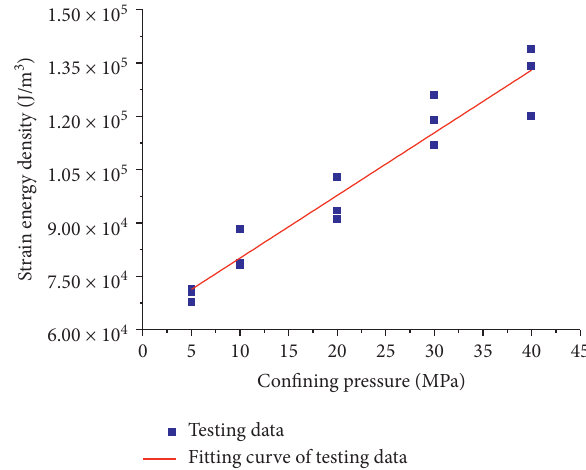
Figure 4: Linear elastic strain energy by the triaxial compressive